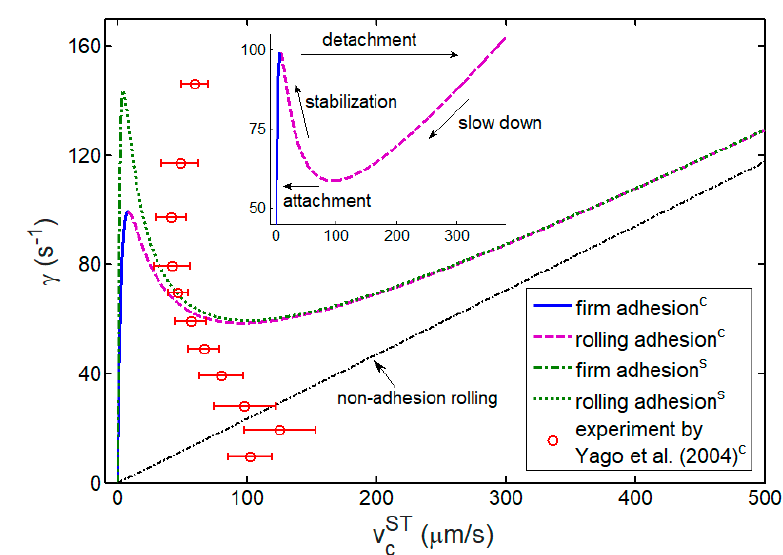
Figure 9. Steady speed of cell, v ST c , as a function of shear rate of flow, γ . The superscripts c and s in the legend mark the catch-bond- and slip-bond-mediated cell adhesion, respectively. The blue solid and green dash–dot lines denote the firm adhesion state where the cell exhibits a slow motion. The purple dash and green dot lines represent the rolling adhesion state where the cell rolls along the substrate at a relatively high speed. The black dash–dot line means the non-adhesion rolling state, where the cell freely rolls without adhesion interaction between cell and substrate. The red circles are experimental results of neutrophils rolling on P-selectin glycoprotein ligand-1 (PSGL-1)-coated substrate under shear flow by Yago et al. [46], in which the P-selectin–PSGL-1 complex shows a typical catch behavior under tensile force. The inset is a partially enlarged drawing for the shear rate ranging from 45 s − 1 to 105 s − 1 and shows bistable processes of cell adhesion in a shear flow.